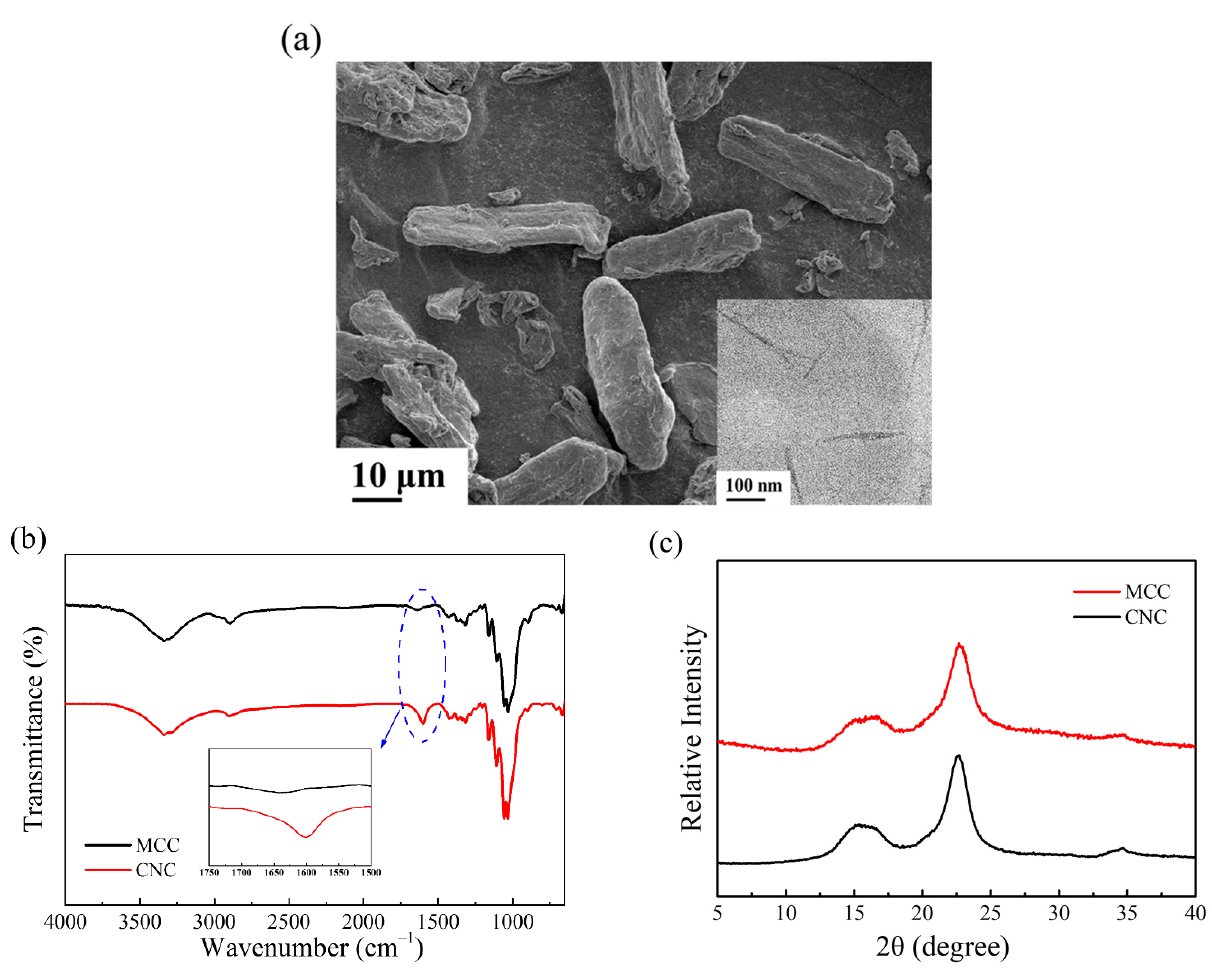
Figure 2. ( a ) SEM and TEM (insert) images, ( b ) FTIR spectrum, and ( c ) WAXD patterns of CNC and